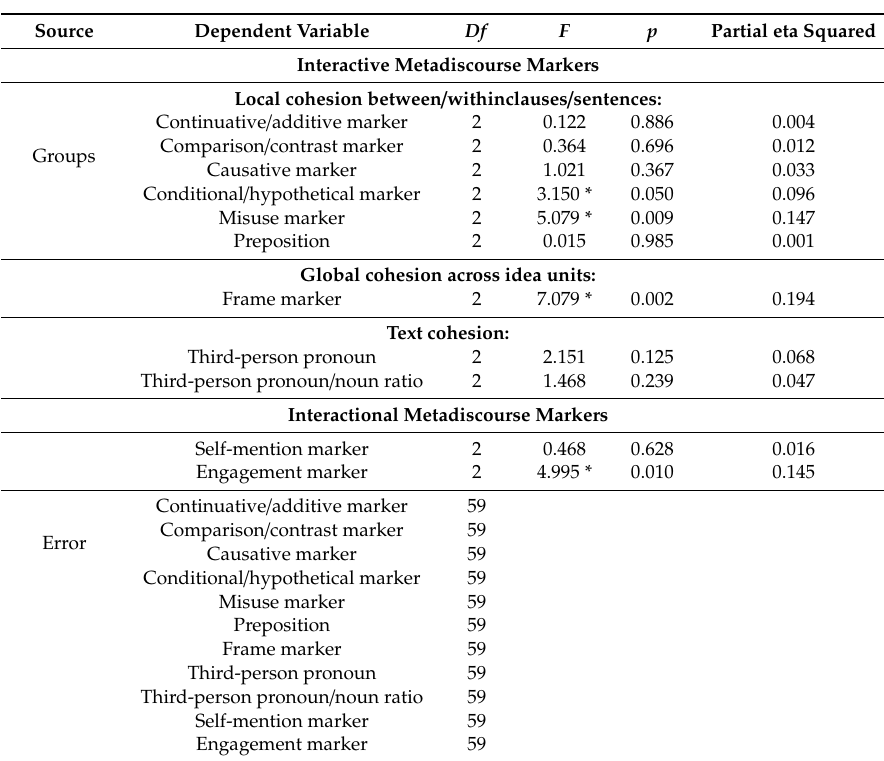
Table 5. Textual organizational measures tests of between-subjects effects.